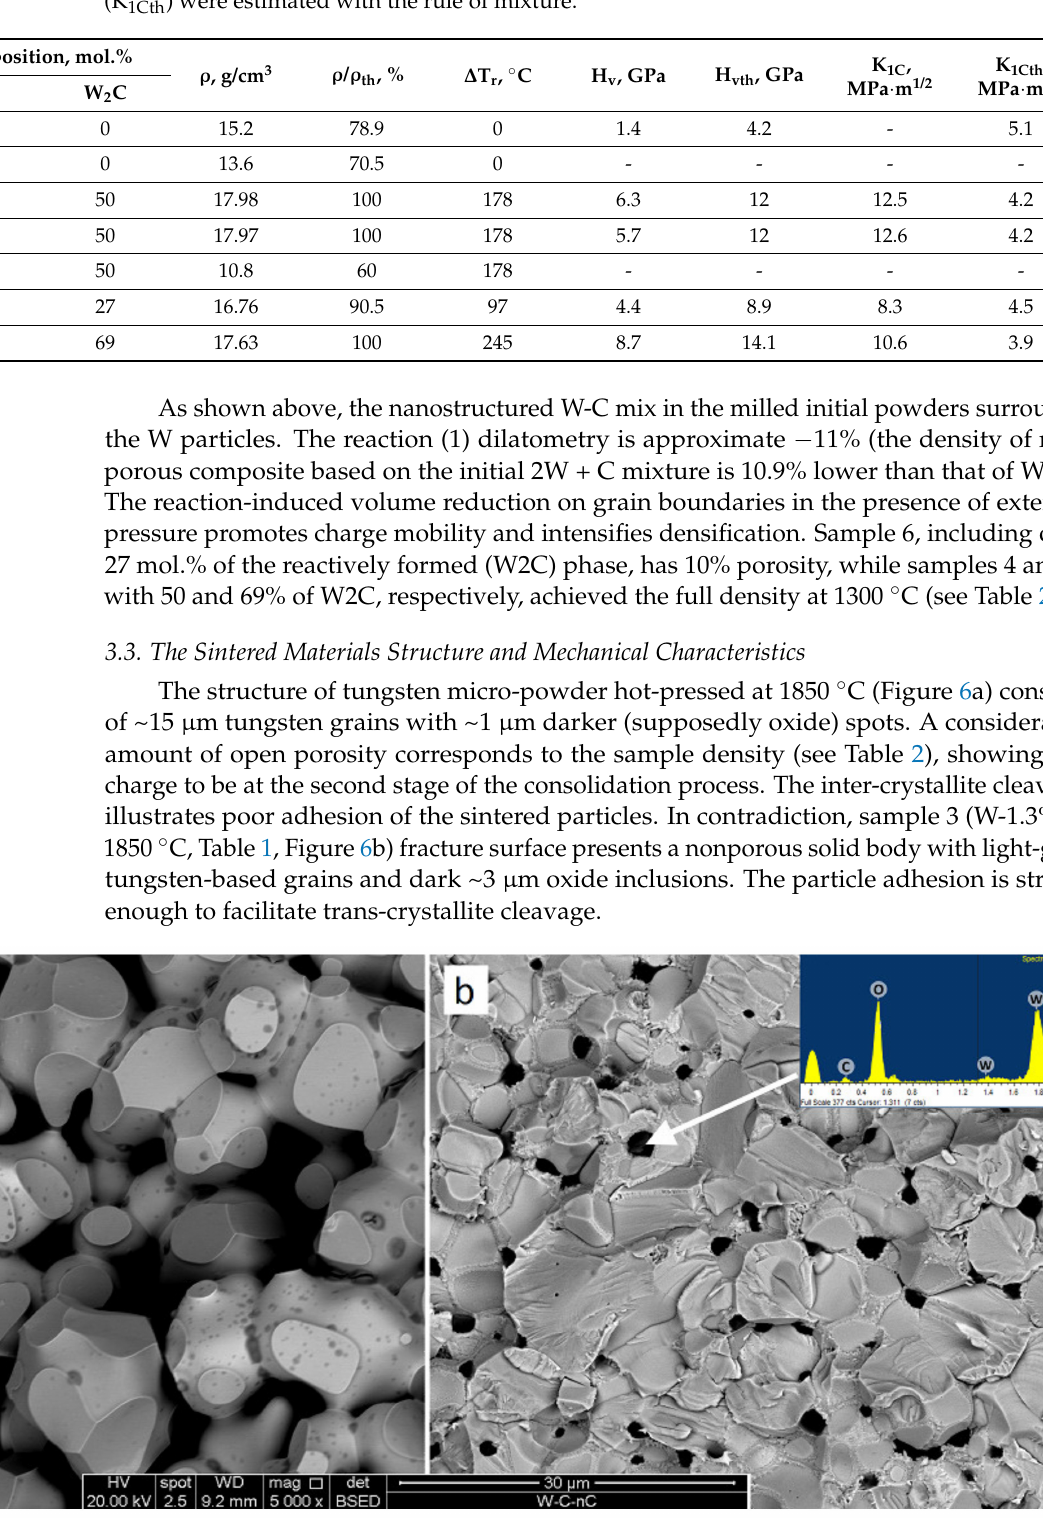
Figure 6. Fracture surfaces of pure tungsten ( a ) and W + 1.3% C with the point EDX analysis ( b ). Both samples (Samples 1 and 3) were sintered at 1850 ◦ C. BSE